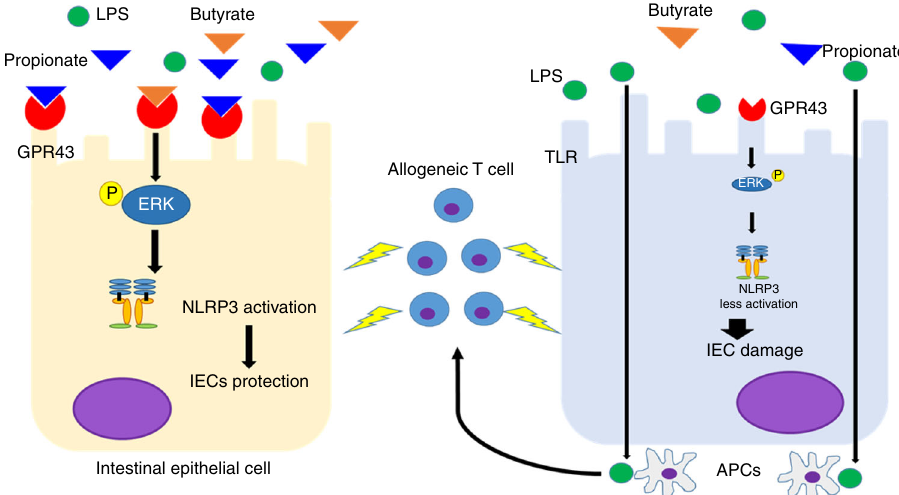
Fig. 7 Model illustrating role of GPR43 on IECs after allo-BMT. In the context of injury and in fl ammation caused by alloreactive T cells and PAMPs such as LPS, SCFAs engage GPR43 and promote ERK phosphorylation dependent activation of NLRP3 in IECs that protects them and mitigates damage induced by GVHD (left). Reduction in expression of GPR43 reduces ERK phosphorylation dependent activation of NLRP3 and aggravates GVHD induced IEC damage and barrier breach allowing for greater translocation of PAMPs such as LPS which further amplify the in fl ammation and damage